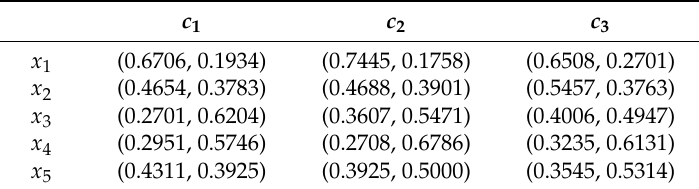
= (( ξ )) il , η il 5 × 3 5 × 3